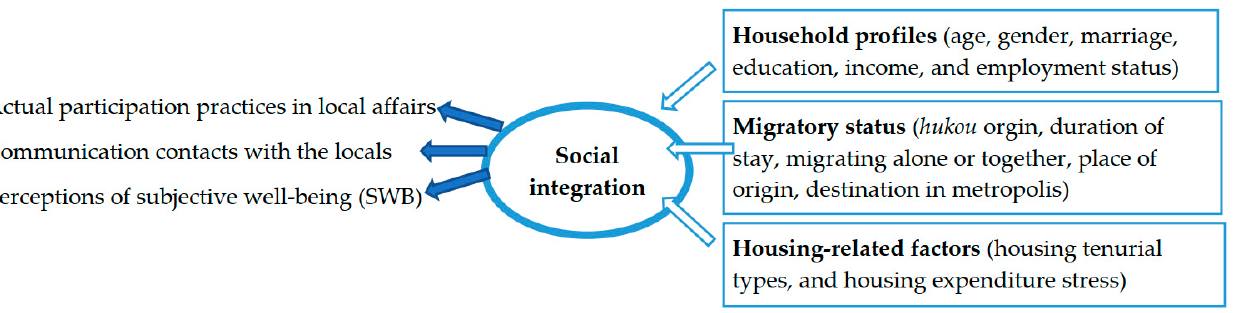
Figure 2. The three-tiered measurement of social integration (practical, relational, and perceptual), and its determinants (household, migratory, and housing-related). Originated and adapted from Ager and Strang’s conceptualization and Chen and Wang’s empirical studies in the Chinese megacity contexts [52,54].